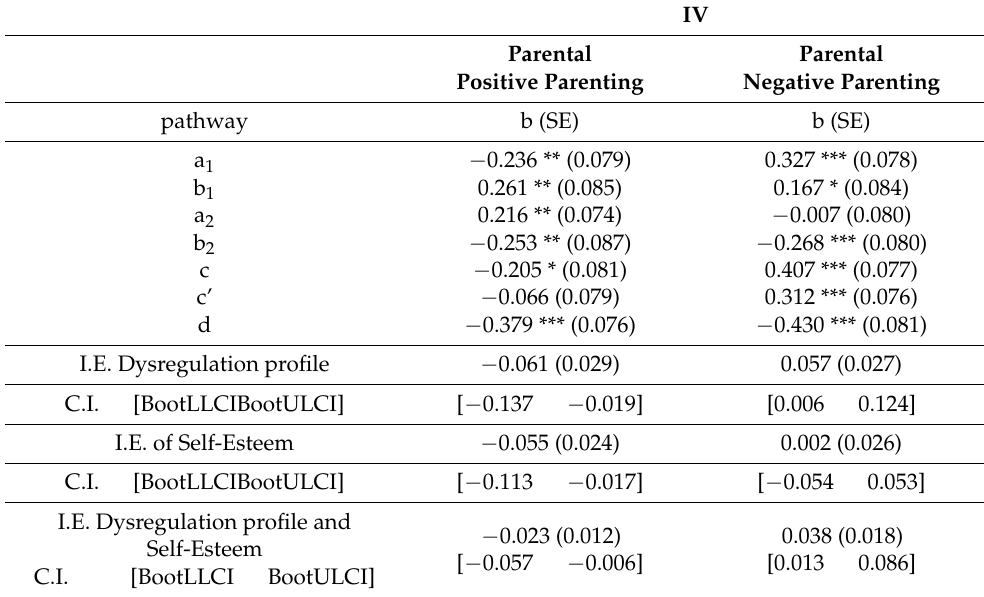
Table 3. Path coefficients of the parallel and serial mediation models predicting children’s problematic internet use (DV) from positive and negative parenting style (IV), through the child’s dysregulation profile (M1) and self-esteem (M2). IV Parental Parental Positive Parenting Negative Parenting pathway b (SE) b (SE) a 1 − 0.236 ** (0.079) 0.327 *** (0.078) b 1 0.261 ** (0.085) 0.167 * (0.084) a 2 0.216 ** (0.074) − 0.007 (0.080) b 2 − 0.253 **